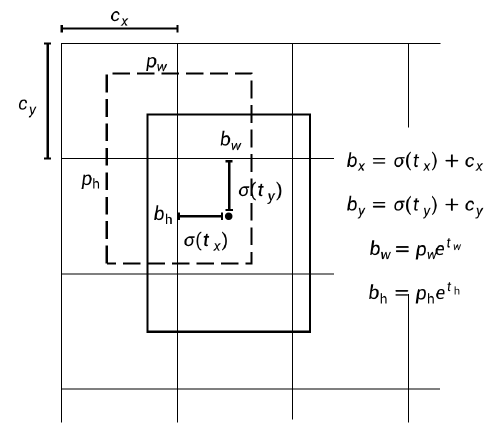
Figure 12. Schematic diagramof calculation of b x , b y , b w , b h .